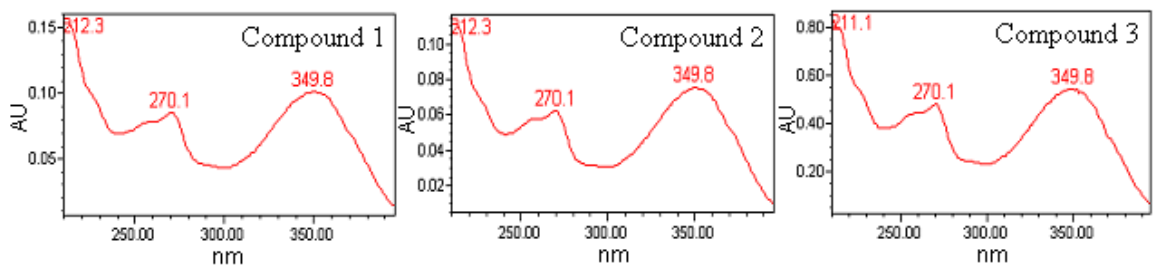
Figure 6. UV spectra of the three antioxidant